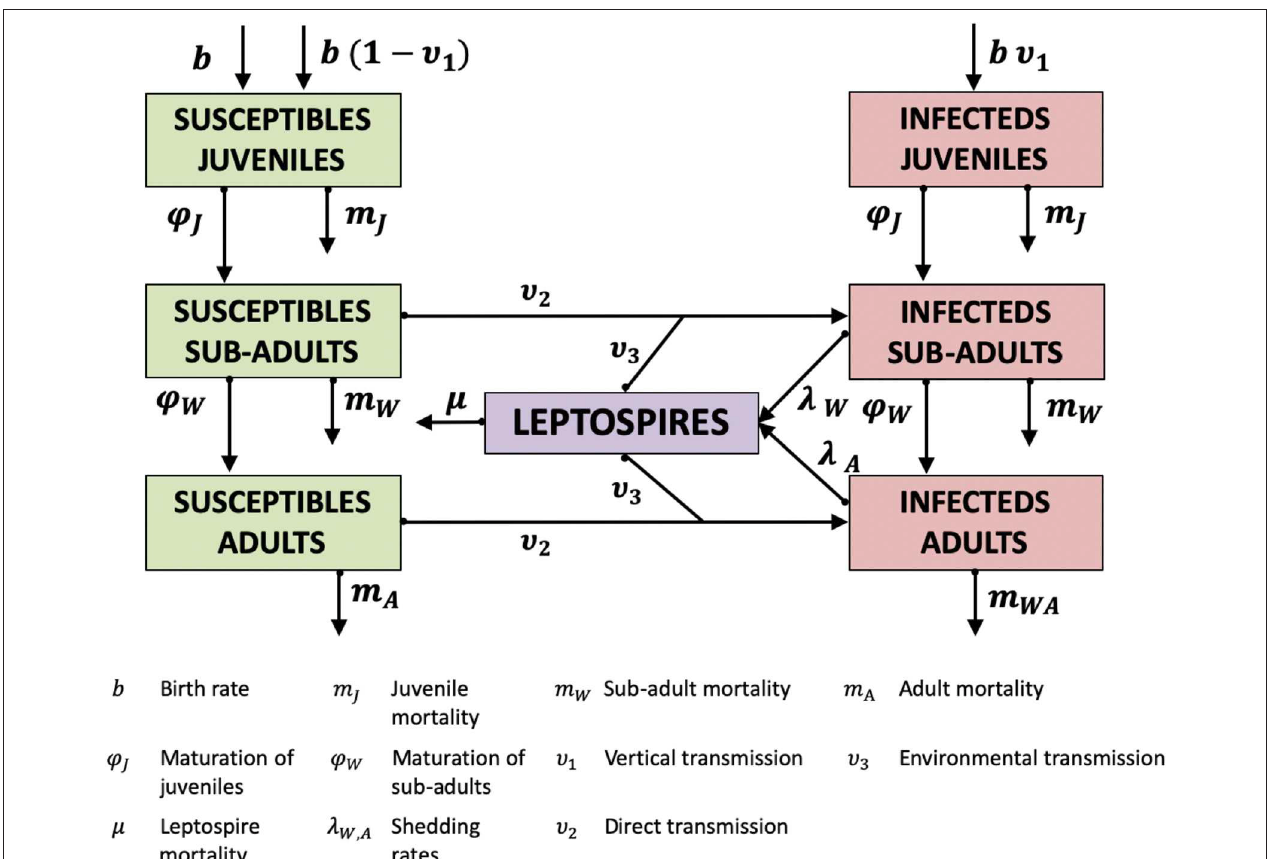
FIGURE 1 | Flow diagram of the age structured model with self-regulation incorporated.